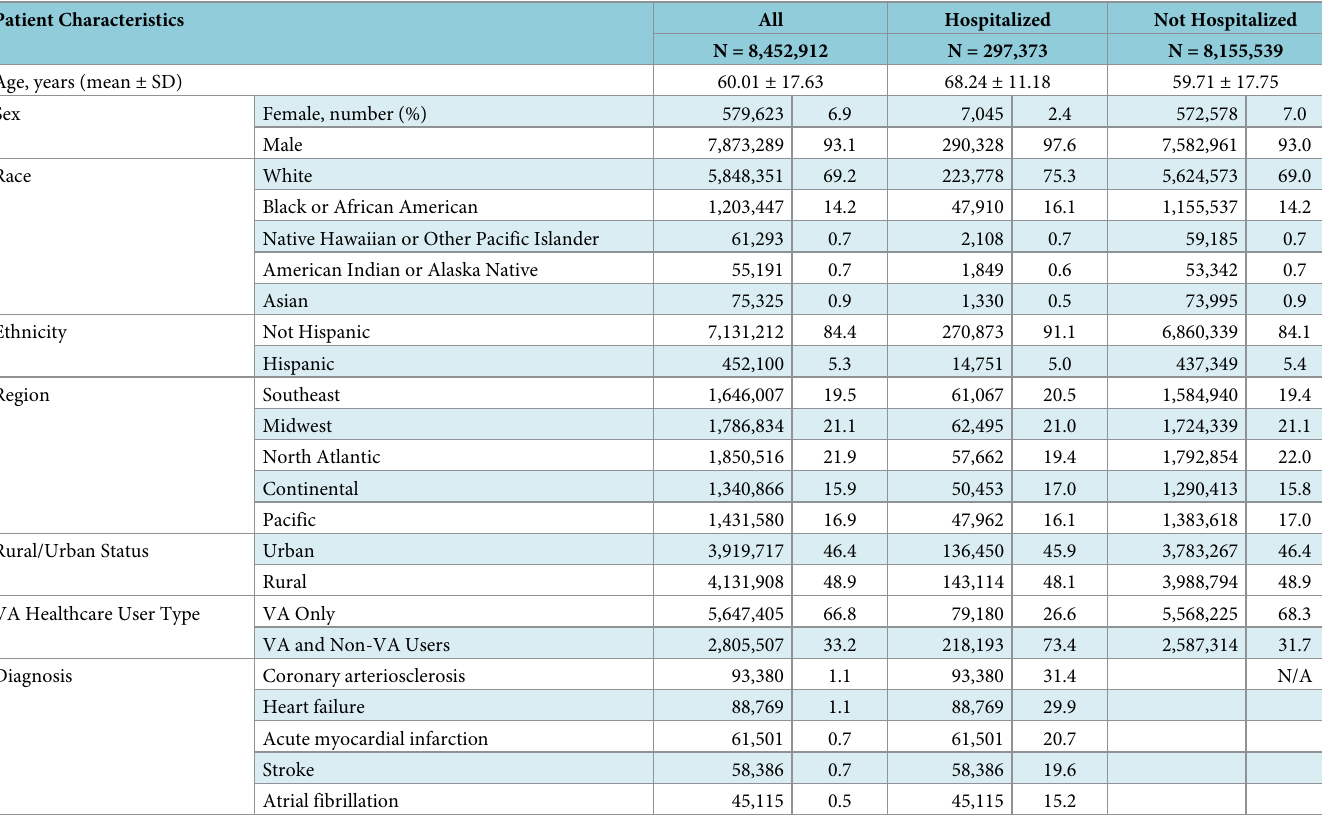
Table 1. Characteristics of veterans hospitalized vs. not hospitalized for one or more of the top 5 cardiovascular conditions between 2010 and 2014 (cid:3) †. Patient